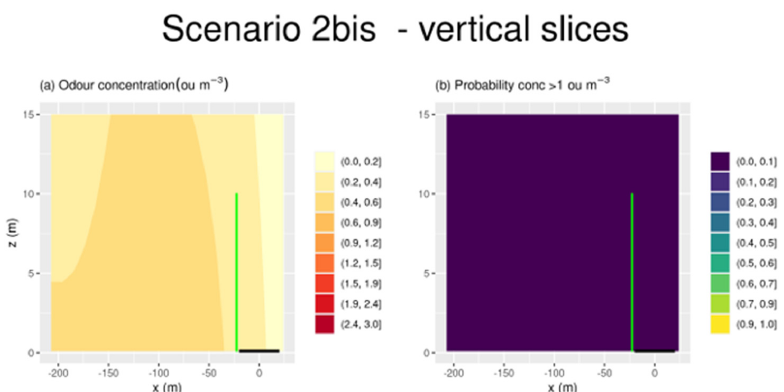
Figure 14. Vertical slices of the odour concentrations ( a ) and exceedance probability of the 1 ou m − 3 threshold ( b ) from ground to a 15 m height as simulated by SCICHEM in the presence of a barrier (represented in green in the graphs). The meteorology and total emissions are the same as in the wind gust episode of scenario 2, but with the emission fi eld replaced by a 40 m − diameter circular source, represented by a horizontal black line in the graphs. The coordinate x is expressed as the distance in meters from the center of the source, and z as the height in meters above the ground. The barrier is represented as a green rectangle.